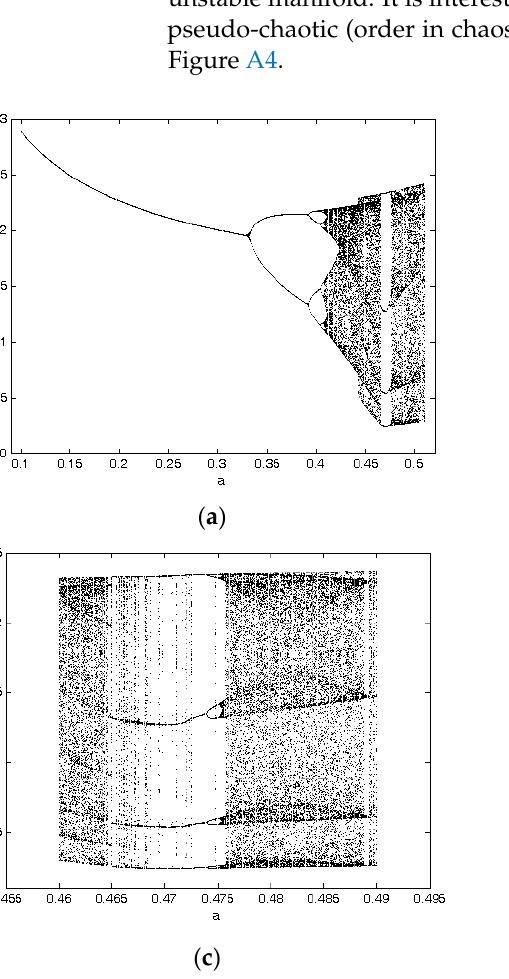
( ) ( ) ty versus b ; and ( b , d ) tz versus a , generated by computer solution of the Figure 7. Bifurcation diagrams: ( a , c ) Figure 7. Bifurcation diagrams: ( a , c ) y ( t ) versus b ; and ( b , d ) z ( t ) versus a , generated by computer solution of the system (1) at b = 0.5. The initial conditions are x ( 0 ) = y ( 0 ) = z ( 0 ) = 0.1. Note that a ∈ [ 0.1,0.51 ] system (1) at